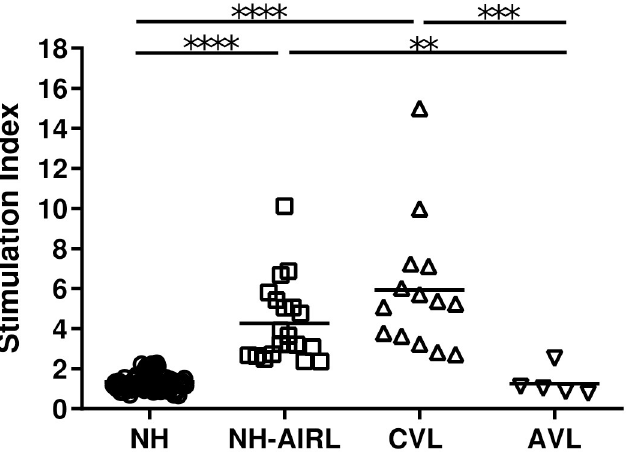
Fig 1. Lymphoproliferative response (CPA test) results following stimulation of their PBMC with SLA. Patients with no history of leishmaniasis who did not respond ( NH n = 74), asymptomatic immune responders to Leishmania ( NH-AIRL n = 20), patients cured of VL ( CVL n = 14), and the five AVL patients (i.e., samples from 5 of the CVL patients during early disease). � p < 0.050, �� p < 0.010, ��� p < 0.001, ���� p < 0.0001.